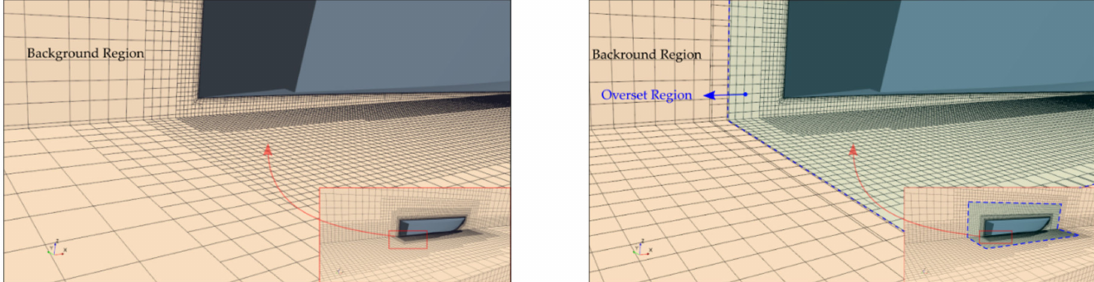
Figure 3. The computational grids around the deep-V stepless boat. Left and Right panels show the fine grids generated for the cases of morphing and overset approaches,